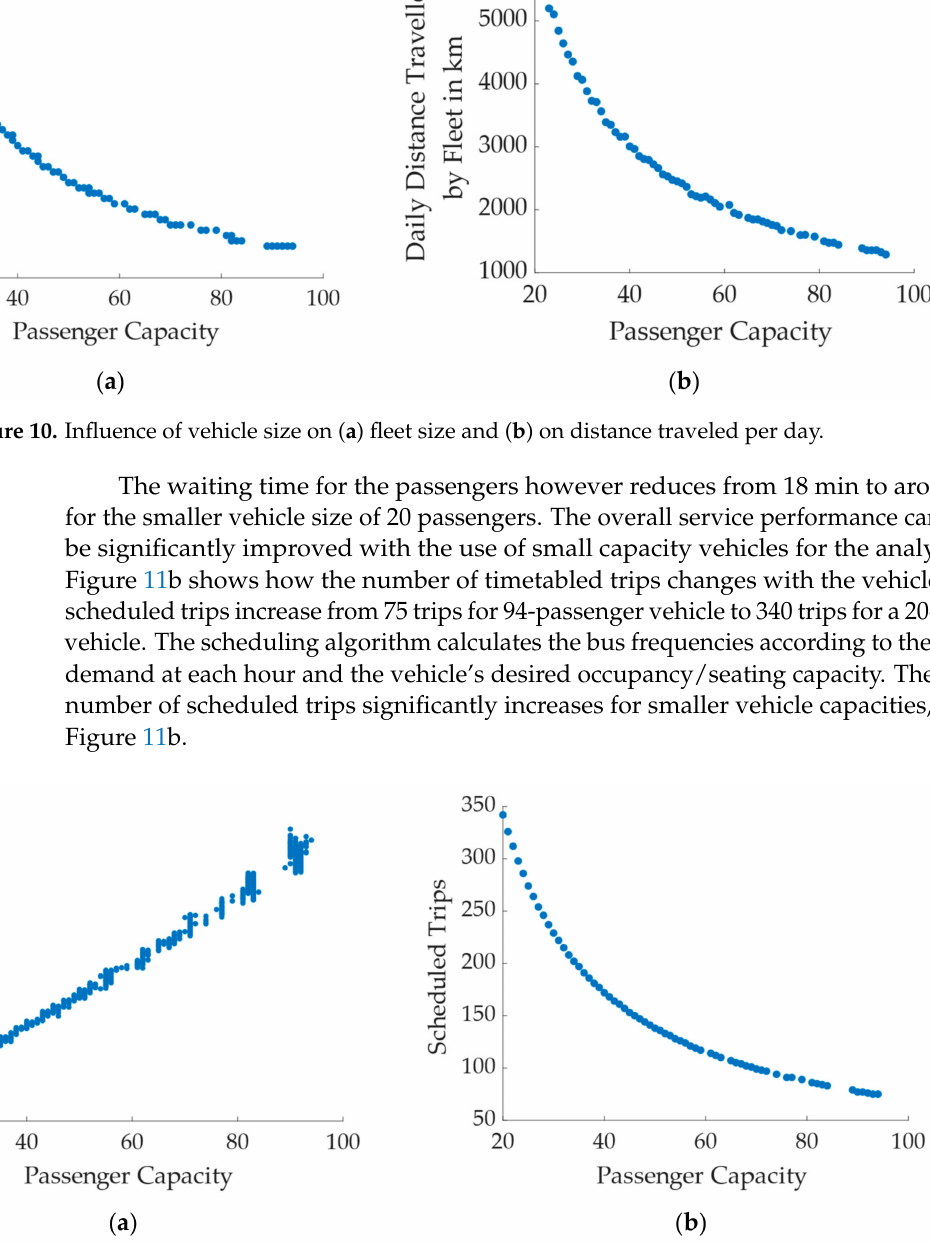
Figure 11. Influence of vehicle size on ( a ) passenger waiting time, and ( b ) number of scheduled